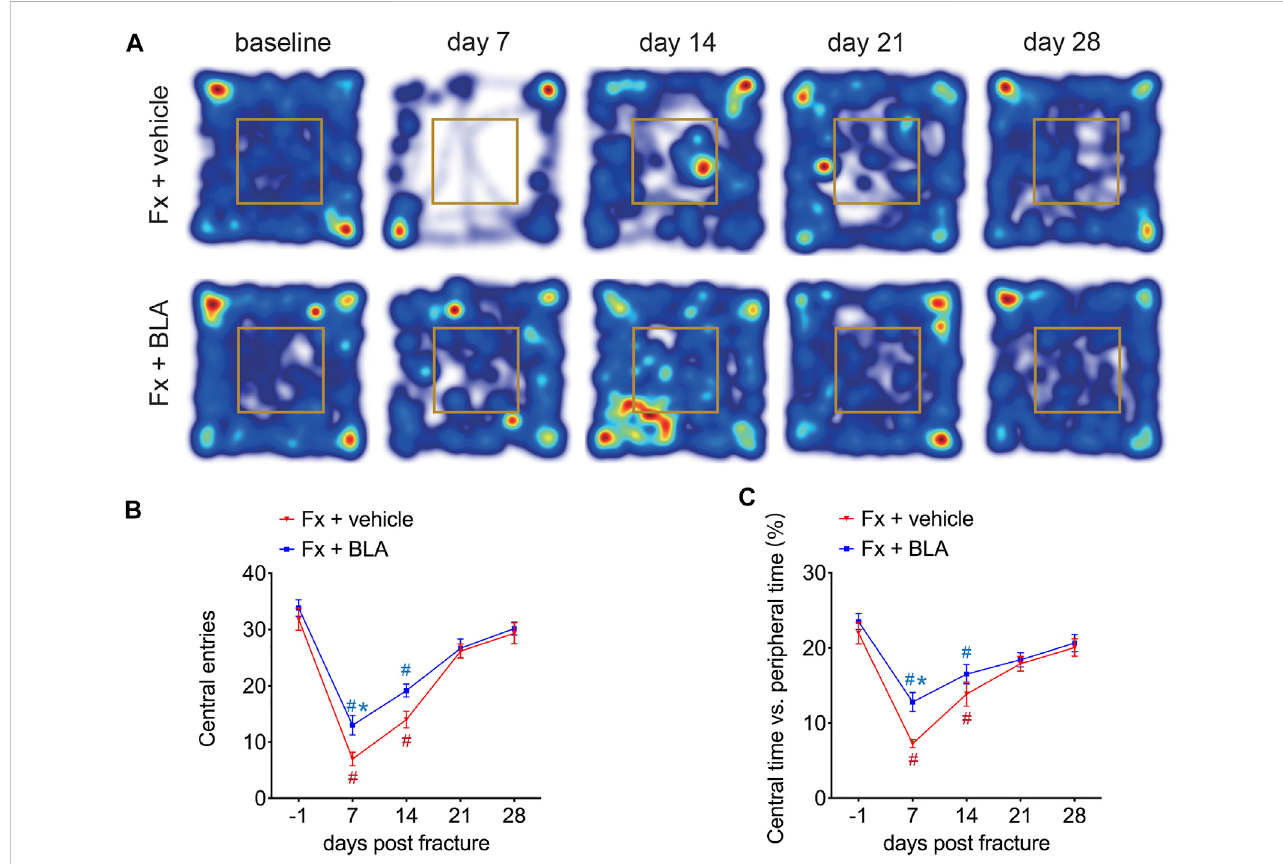
FIGURE 3 The Effects of BLA on anxiety-like behaviors in fracture mice. (A) Representative Heat maps of open- fi eld test comparing movement traces between fracture micetreatedwithBLAorvehicle. (B) Quantitativeanalysis ofentriestothecentralareaofthetwogroups. N =6pergroup. (C) Quantitative analysis of time exploring the central area of the two groups. N = 6 per group. Values are expressed as mean ± SEM. Two-way repeated-measures ANOVA, Dunnett ’ s multiple-comparisons test for differences within each group: # p < 0.05 when compared with baseline (day-1); Bonferroni ’ s multiple-comparisons test for differences between groups: * p < 0.05 when compared with vehicle